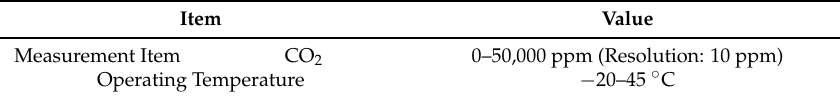
Table 2. Performance and specifications of the multi-gas analyser.